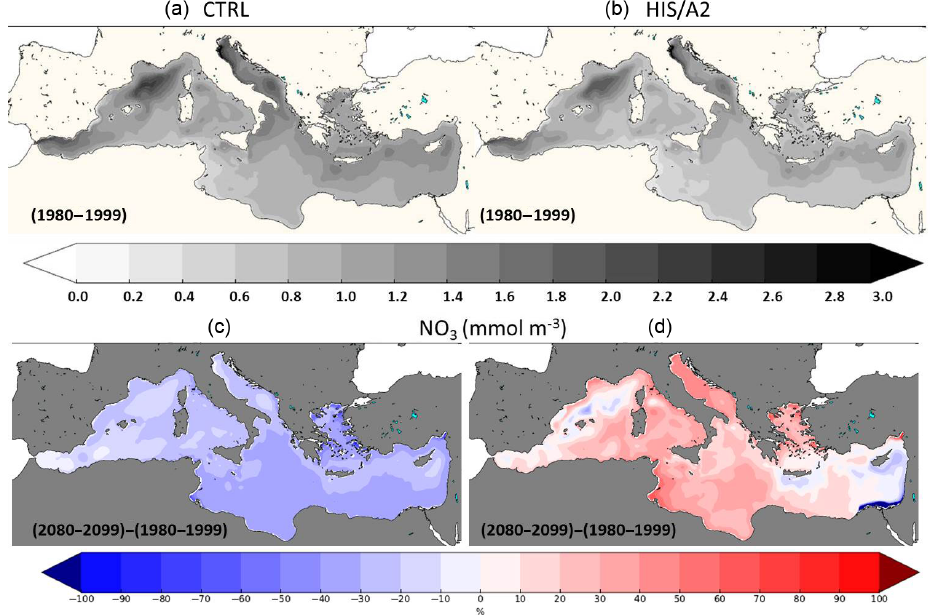
Figure 9. Present (1980–1999, top) interannual average surface (0–200m) concentrations of nitrate (10 − 3 molm − 3 ) in the CTRL (a, c) and HIS/A2 (b, d) simulations. The bottom maps show the percentage of relative difference between the 2080–2099 and the 1980–1999 periods in the CTRL (a, c) and HIS/A2 (b, d) simulations.